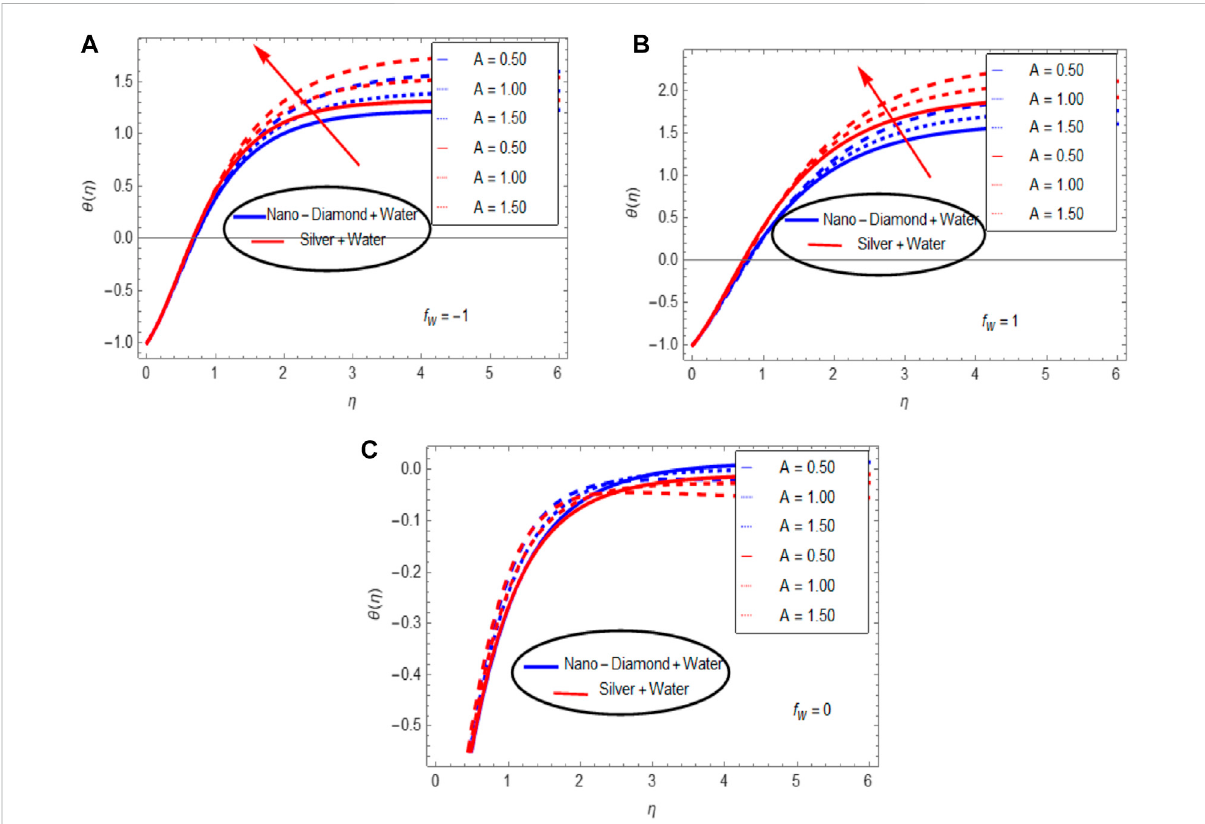
FIGURE 4 In fl uence of the unsteadiness parameter in the presence of (A) suction, (B) injection, and (C) without suction/injection on the temperature